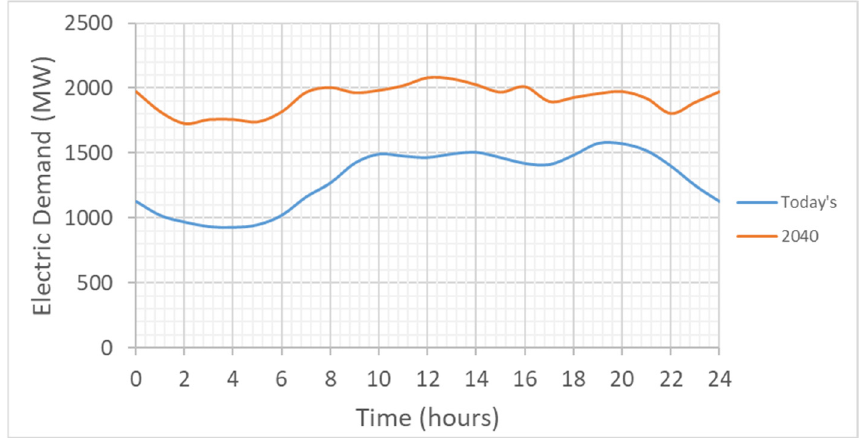
Figure 4. Current electricity demand profile and forecast of the Canary Archipelago for 2040.